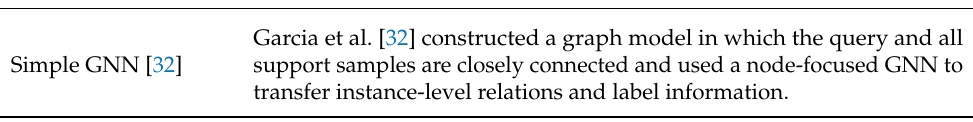
Table 2. Some of the current GNN models for few-shot tasks and their descriptions.